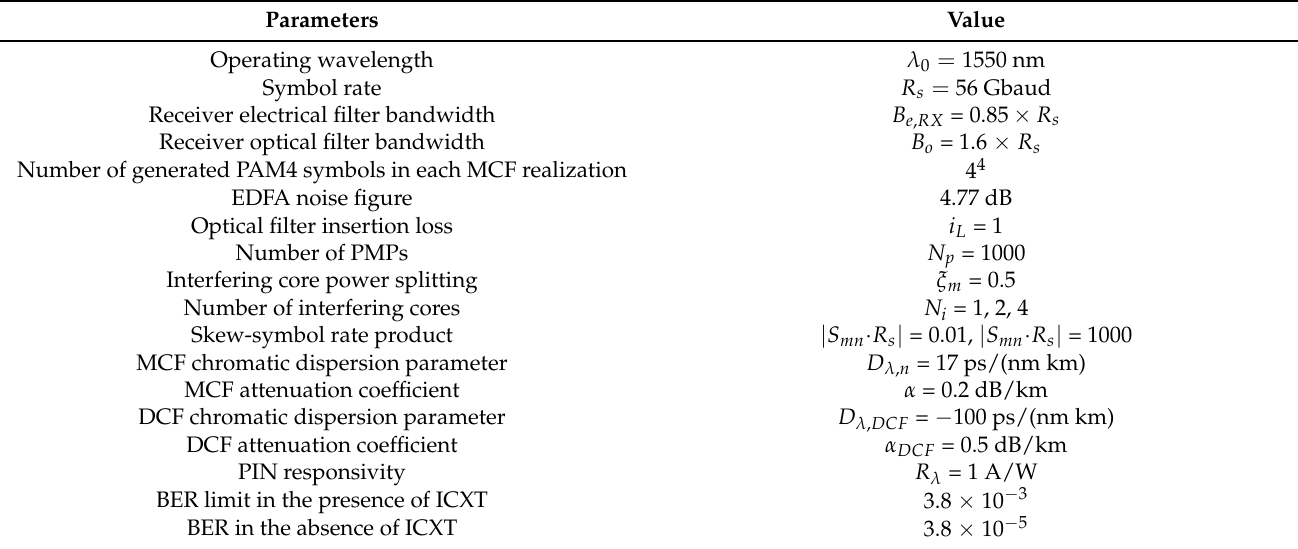
Table 1. System and simulation